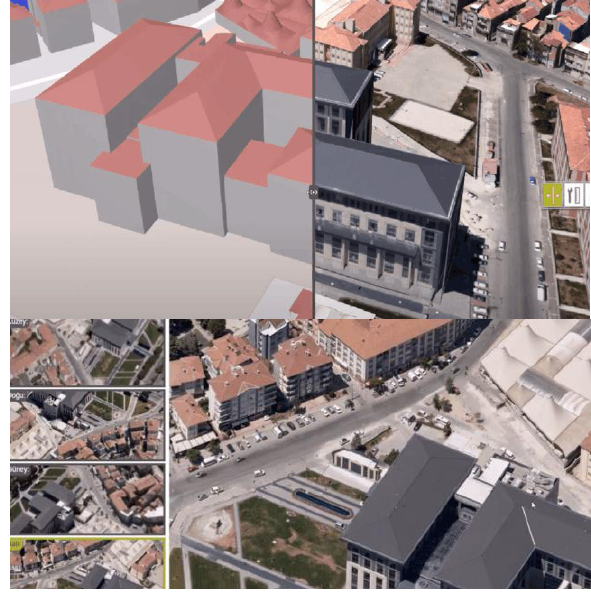
Figure 8. Example of Visualization-2